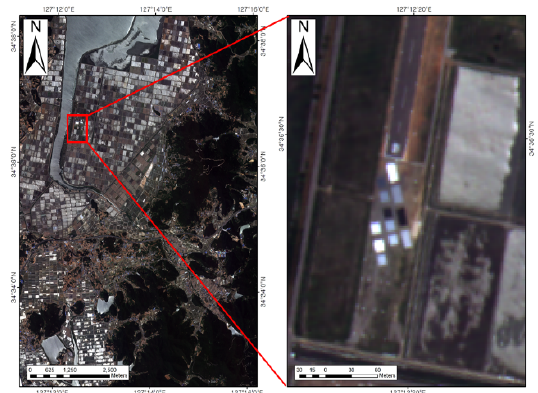
Figure 3. KOMPSAT-3A and Landsat-8 image in Libya-4